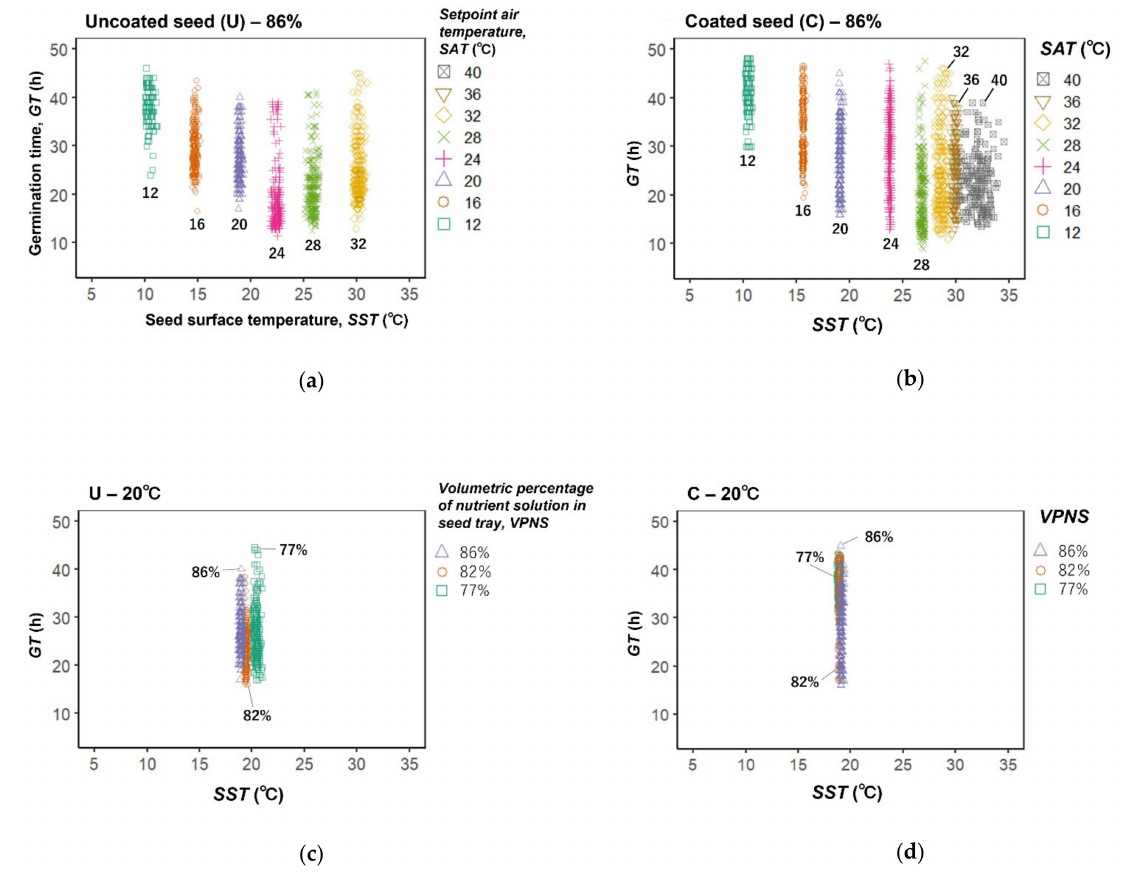
Figure 6. Scatter diagram of germination time ( GT ) and seed surface temperature ( SST ) under (1) di ff erent setpoint air temperature ( SAT ) and volumetric percentage of nutrient solution in seed tray ( VPNS ) of 86% each with 300 ( a ) uncoated seeds—U and ( b ) coated seeds—C, (2) di ff erent VPNS and SAT of 20 ◦ C with U ( c ) and C ( d ). Each symbol corresponds to one seed (see Table 1 for